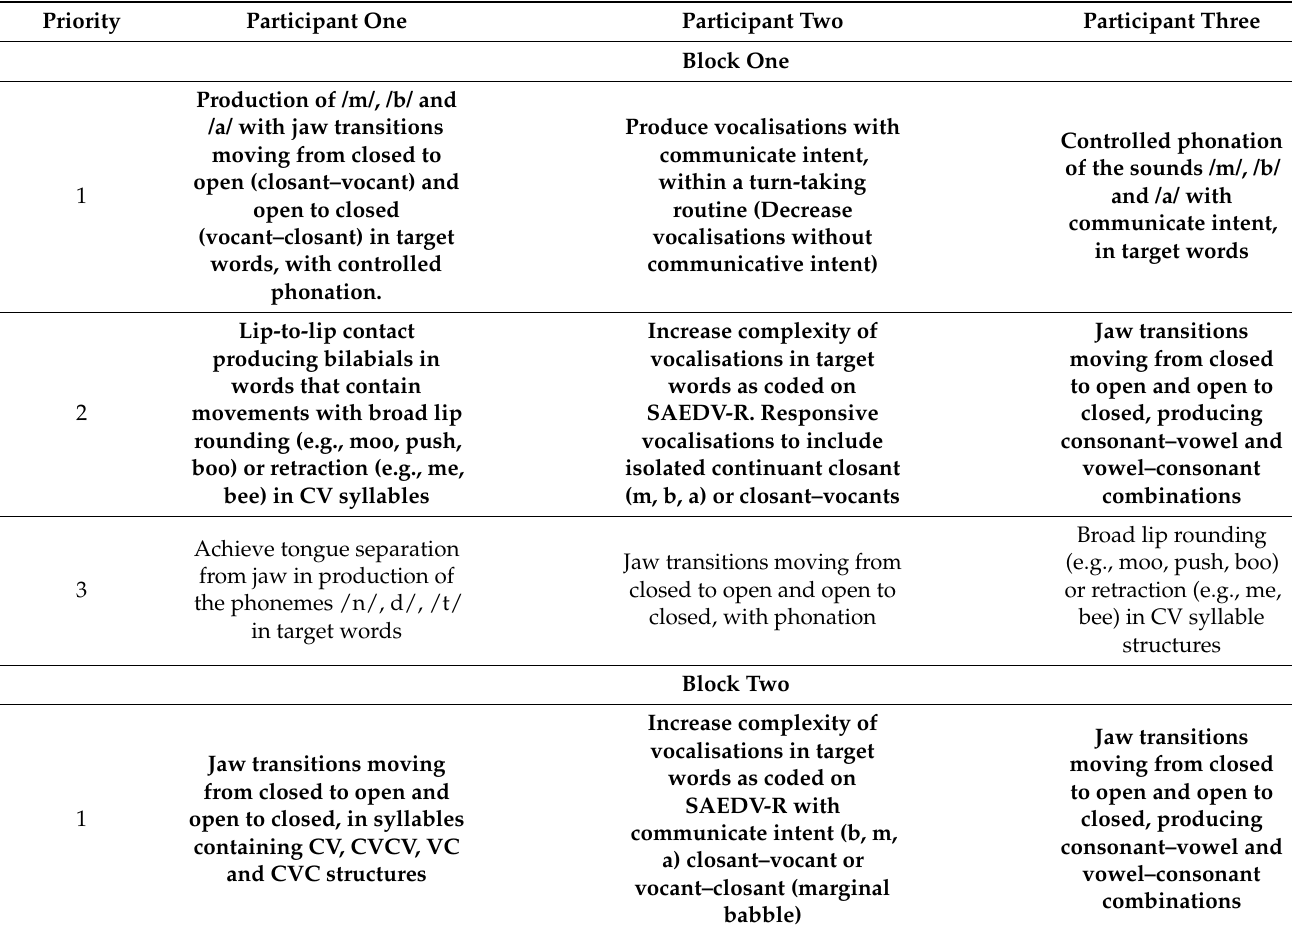
Table 3. Intervention Priorities for each Participant across the Three Intervention